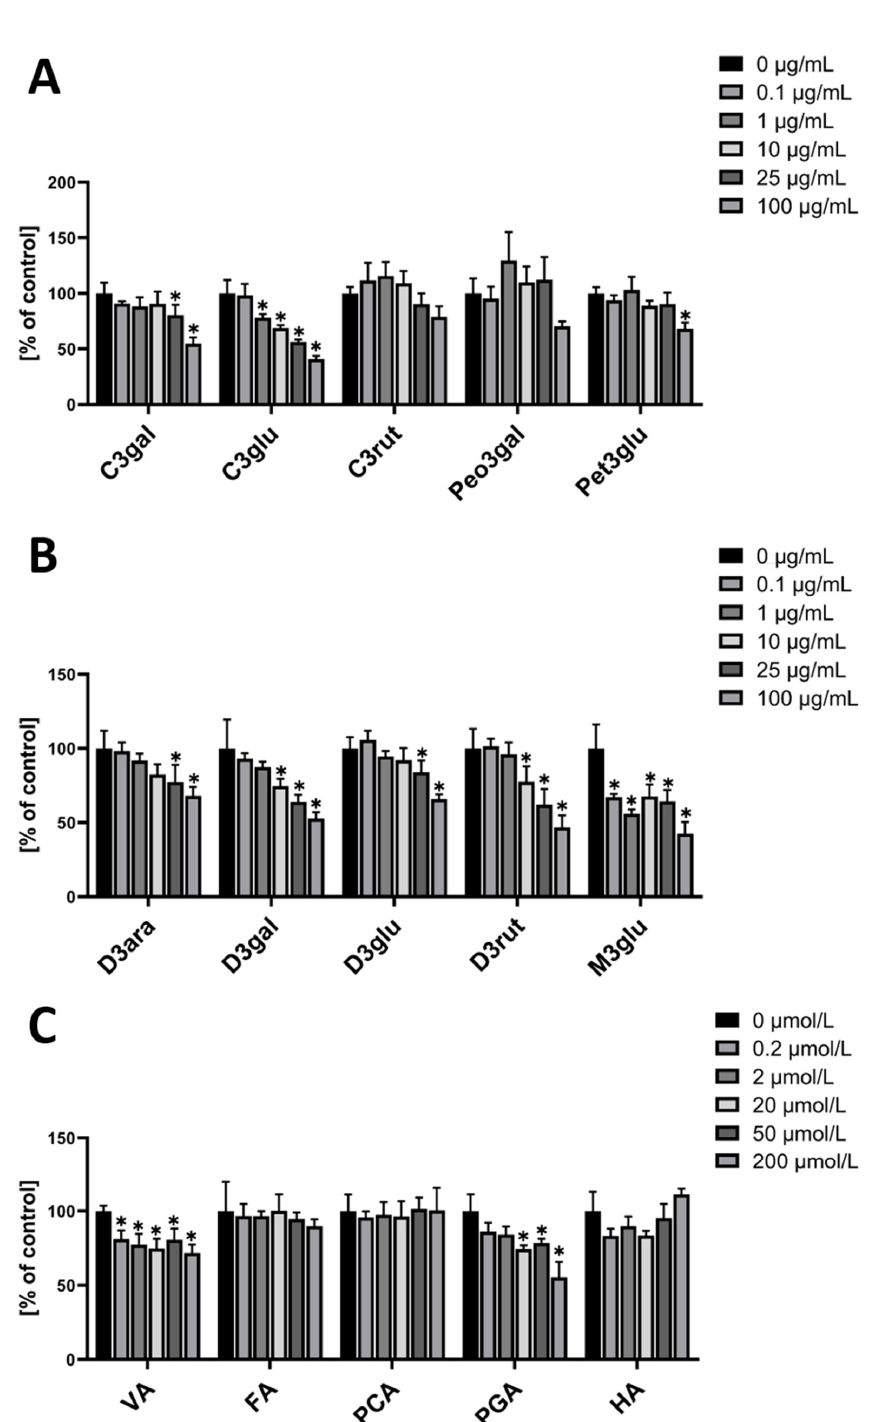
Figure 3. DCF-DA fluorescence relative to control in HUVEC with the respective concentrations of single anthocyanins ( A , B ) and the respective concentrations of anthocyanin metabolites ( C ); results are expressed as mean ± SD; * p < 0.05 compared to 0 µg/mL of the respective substance; n = 4 technical replicates.